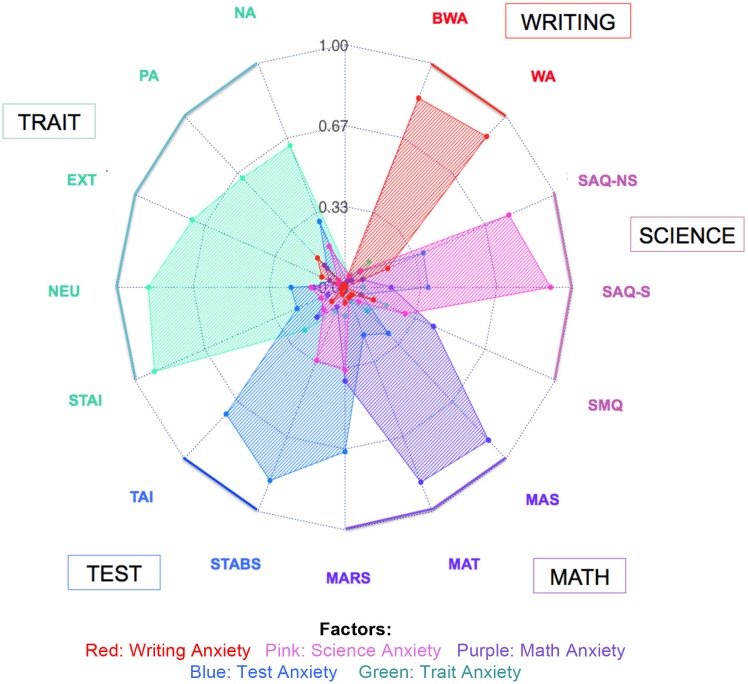
Varimax-rotated factor analysis using single scales in Study 1. Factor scores for each factor are represented for writing, science, math, test, and trait anxiety in the main sample (N = 285). Abbreviations for each scale are listed around the circle. For scale abbreviations, see Table 1. Colors represent the hypothesized domains for each scale (e.g., the MARS is hypothesized to represent math anxiety, the TAI hypothesized to represent test anxiety). Values on the radar plot represent absolute values of the factor loadings for each scale. Zero is represented at the center of the plot, with increasing factor scores radiating out from the center. Values closer to the outside of the plot indicate higher factor loadings.